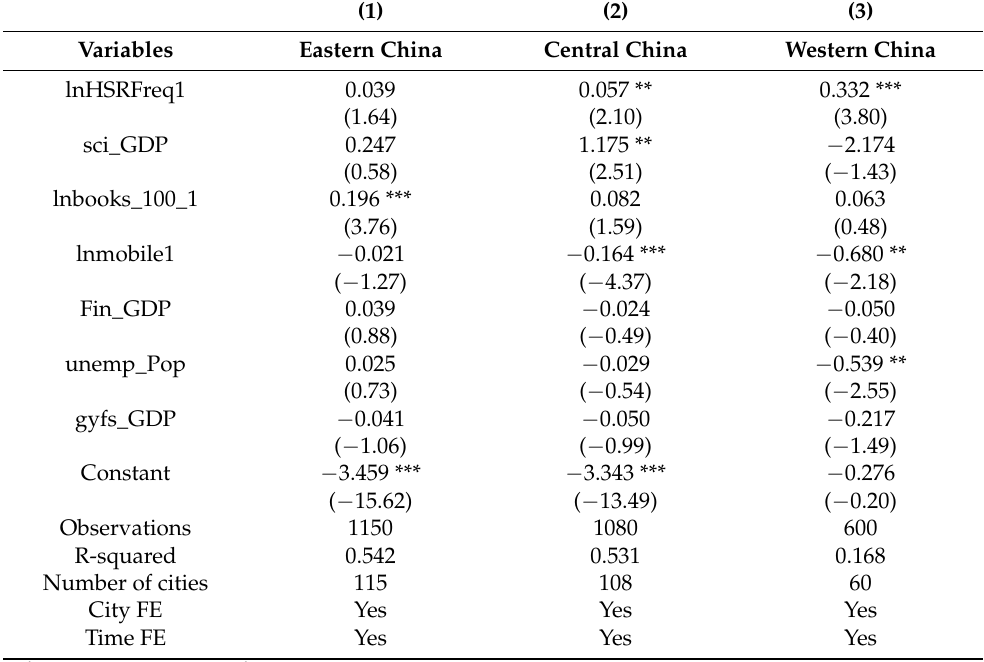
Table 5. The results of the sub-sample regression of eastern, central, and western